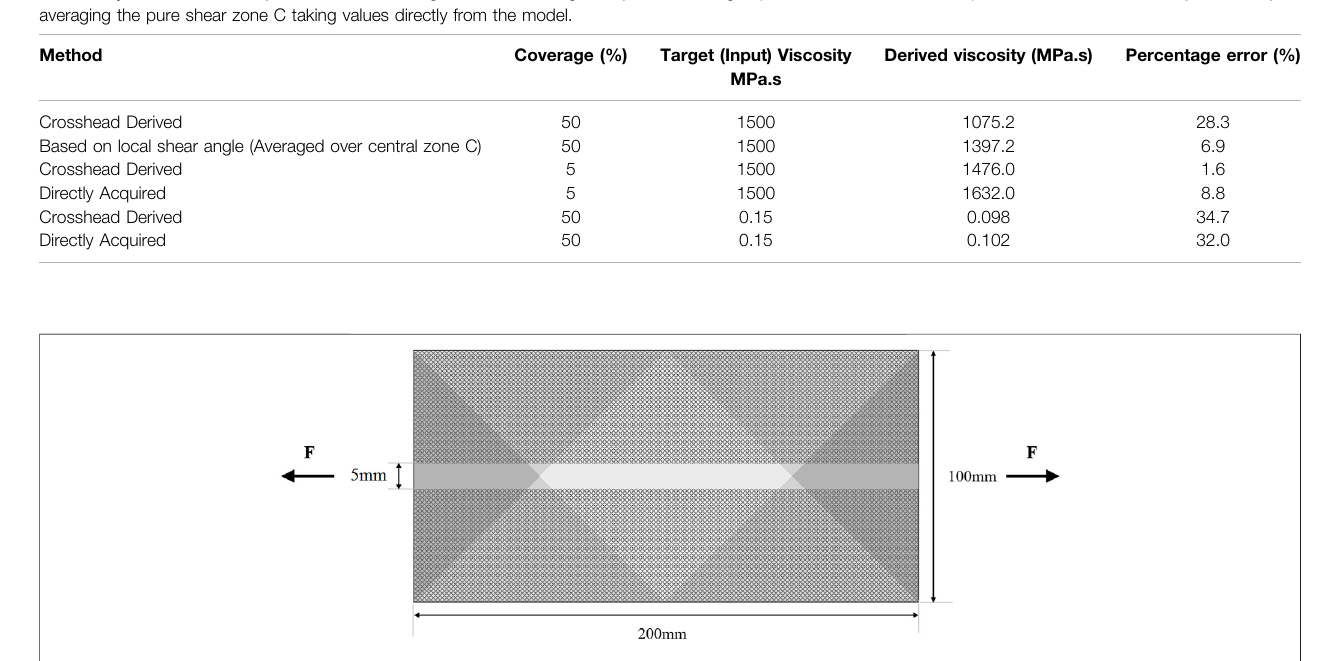
FIGURE 8 | Bias extension test schematic diagram with one central stiffened